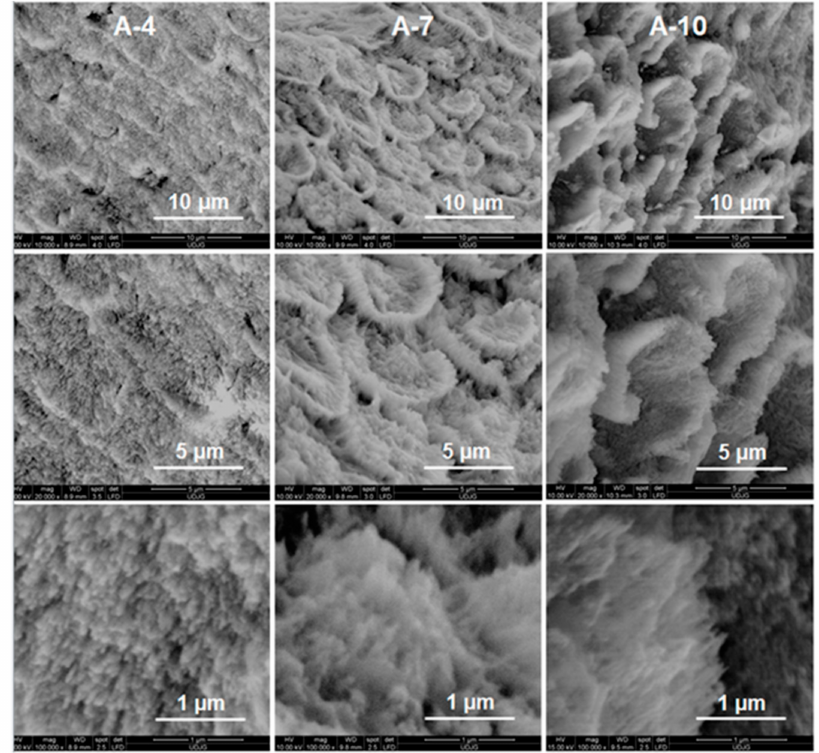
Figure 3. Top-view SEM images of the remineralized acid-etched enamel samples under agarose- based hydrogel for four (A-4), seven (A-7), and ten (A-10)